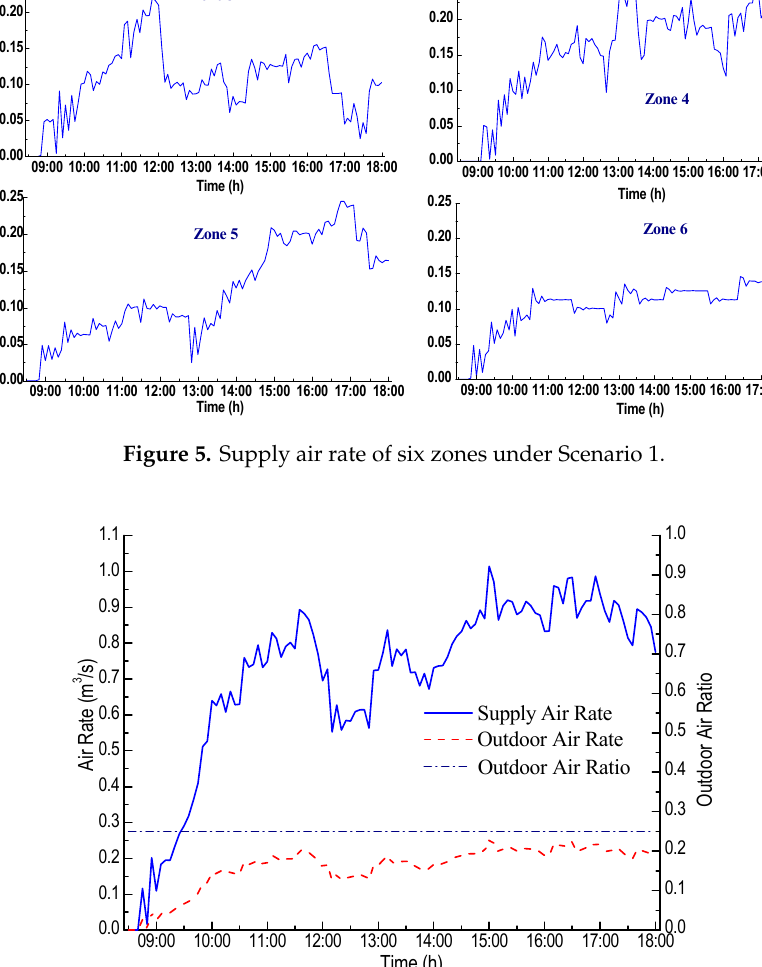
Figure 6. Supply air rate, outdoor air rate, and outdoor air ratio under Scenario 1.